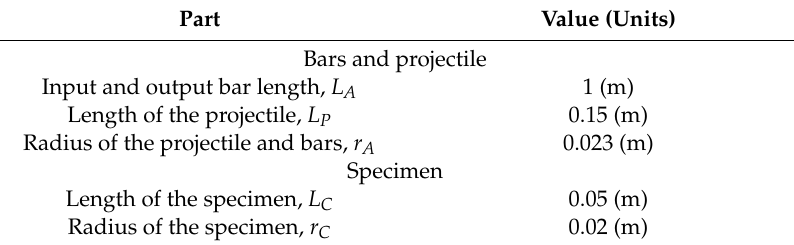
Table 3. Geometry dimensions of the experimental setup from Figure